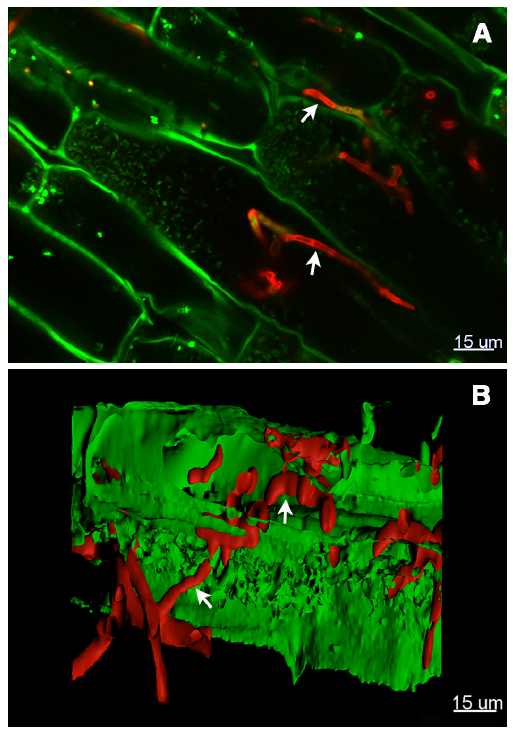
Figure 4. Colonization of canola roots by Heteroconium chaetospira BC2HB1 at 14 days after seeding, observed using confocal microscopy. A: fungal hyphae (arrows) in the cortical tissue of a canola root; B: An animation of a profile view of root colonization by fungal hyphae (red, arrow pointed), constructed from 60 confocal microscopic images taken every 1.5 m m from top to bottom of the root sample (in green color).